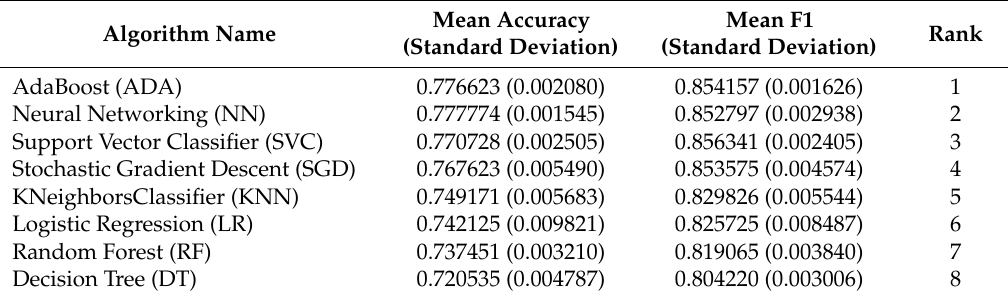
Table 2. Algorithms and their scores for the whole dataset.